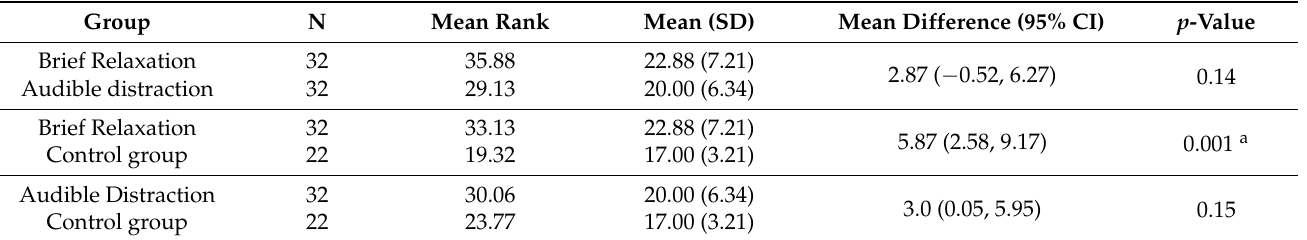
Table 3. Series of comparisons to demonstrate the effectiveness of brief relaxation therapy and audible distraction in reducing anxiety